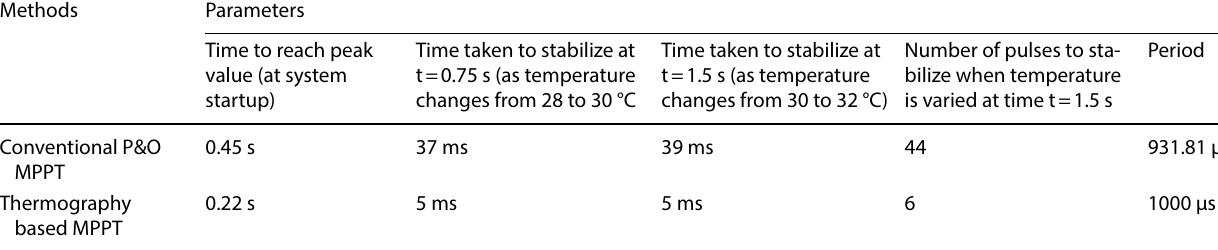
Table 1 Simulation results summary